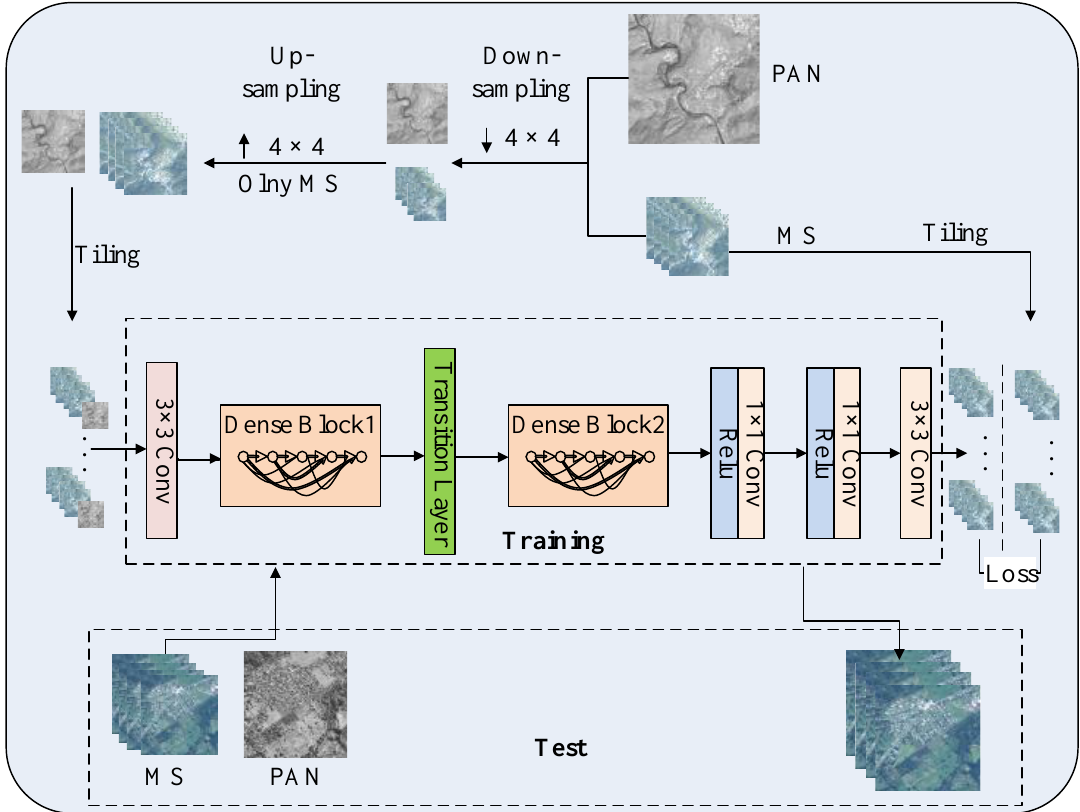
Figure 2. The framework of the densely connected convolutional networks for pan-sharpening (DCCNP)